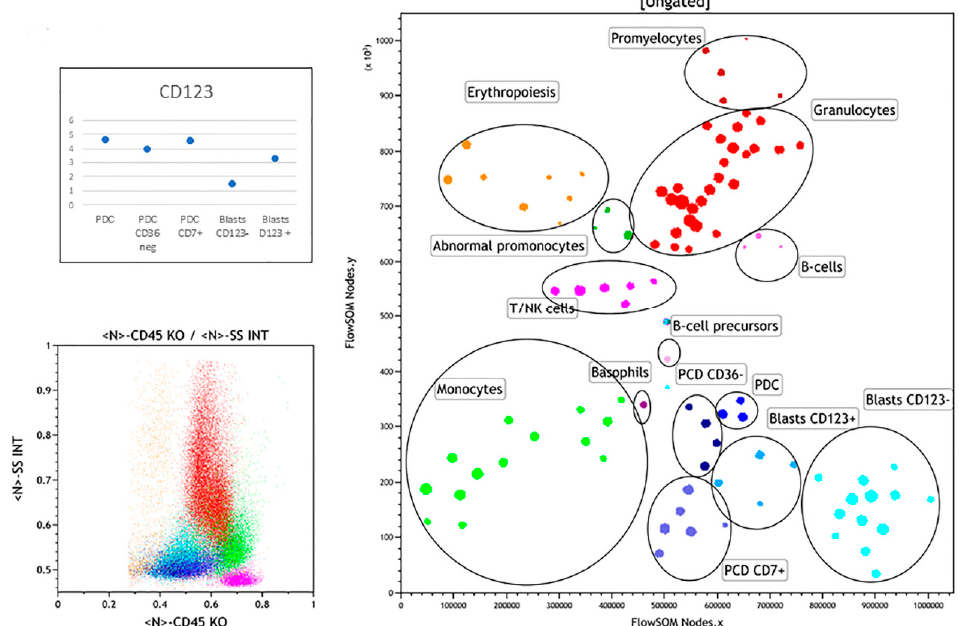
Figure 3. FlowSOM analysis of Case 2. Minimal spanning tree is shown on the right panel. Two different clusters of blast cells are separated on the basis of CD123 expression. Three different PDC clusters are segregated based on CD7 or CD36 expression (Supplementary Table S5). Normalized MFI of CD123 expression in positive cell subsets is given in the upper left diagram and back-gating on the CD45/SSc plot is illustrated on the lower-left panel.